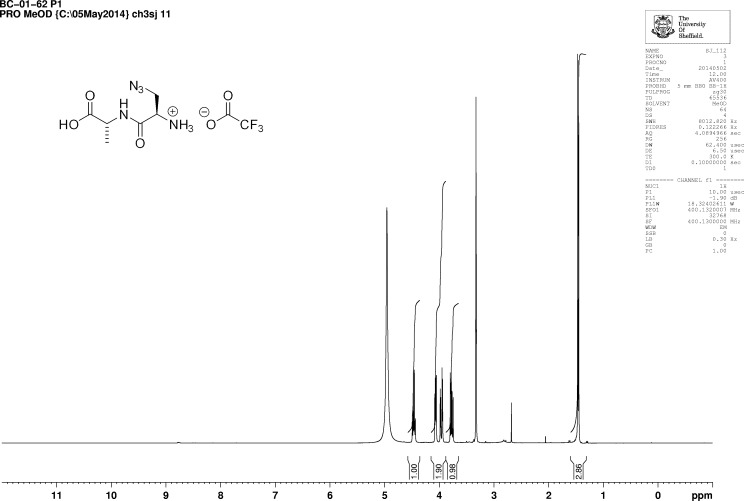
1D 1H NMR Spectrum of 3-Azido-D-alanyl-D-alanine, 2,2,2-trifluoroacetate [D-aza-ala-D-ala (ADA-DA) TFA salt].